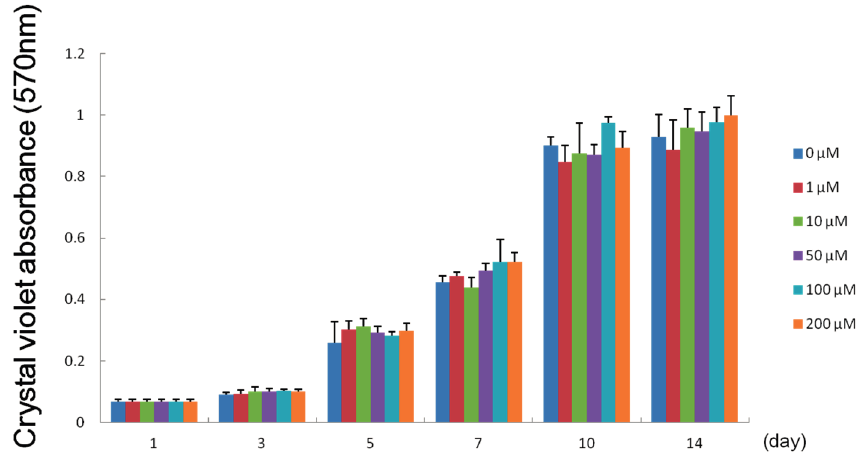
Figure 4. Effect of melatonin on the proliferation of DP-805 cells. DP-805 cells were seeded into 24-well culture plates at a cell density of 1 × 10 4 cell/well and cultured in α -modified Eagle’s Medium ( α -MEM) containing 1% fetal bovine serum (FBS) and a variety of concentrations (0, 1, 10, 50, 100 and 200 µM) of melatonin. The proliferation of DP-805 cells was analyzed using a crystal violet staining method. Melatonin exerted no influence on the proliferation of DP-805 cells at any concentrations not less than 1 µM and not more than 200 µM. Values are the mean ± SD.